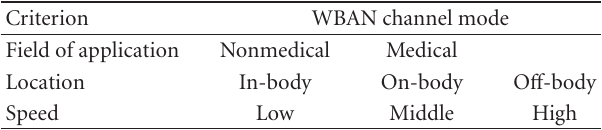
Table 1: Classification of WBAN channel.